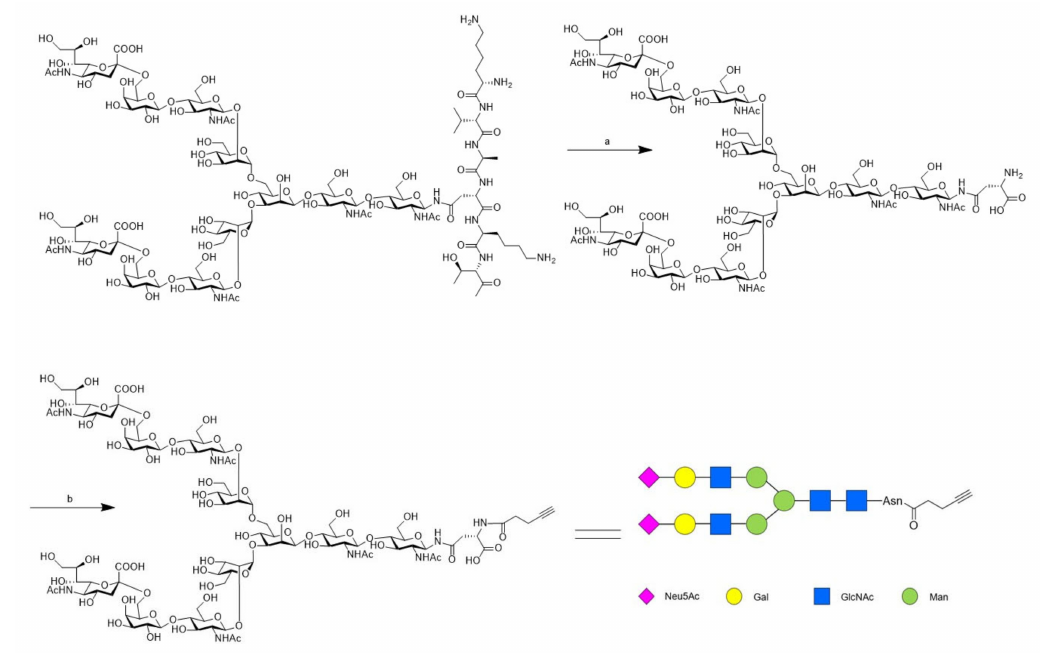
Scheme 1. Synthesis of SCT-Asn-alkyne: ( a ) pronase, 0.5% SDS, 10 mM CaCl 2 , 0.1 M Tris, pH 7.5, 37 ◦ C, 7 d; ( b ) pent-4-ynoic acid succinimidyl ester, H 2 O/DMF (1/1 v/v ), RT, 12